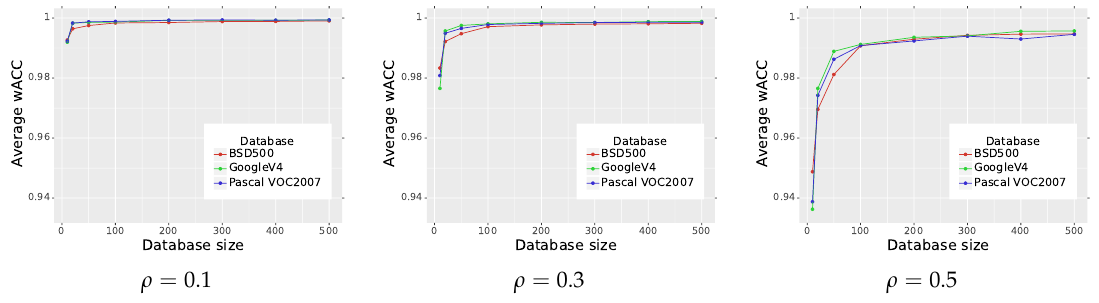
Figure 9. Impact of the type of dataset used in the training and its size on the average wACC of the proposed IDCNN. Table 4. Influence of the dataset type used in the training and its size on the average wACC. The best values are presented in bold